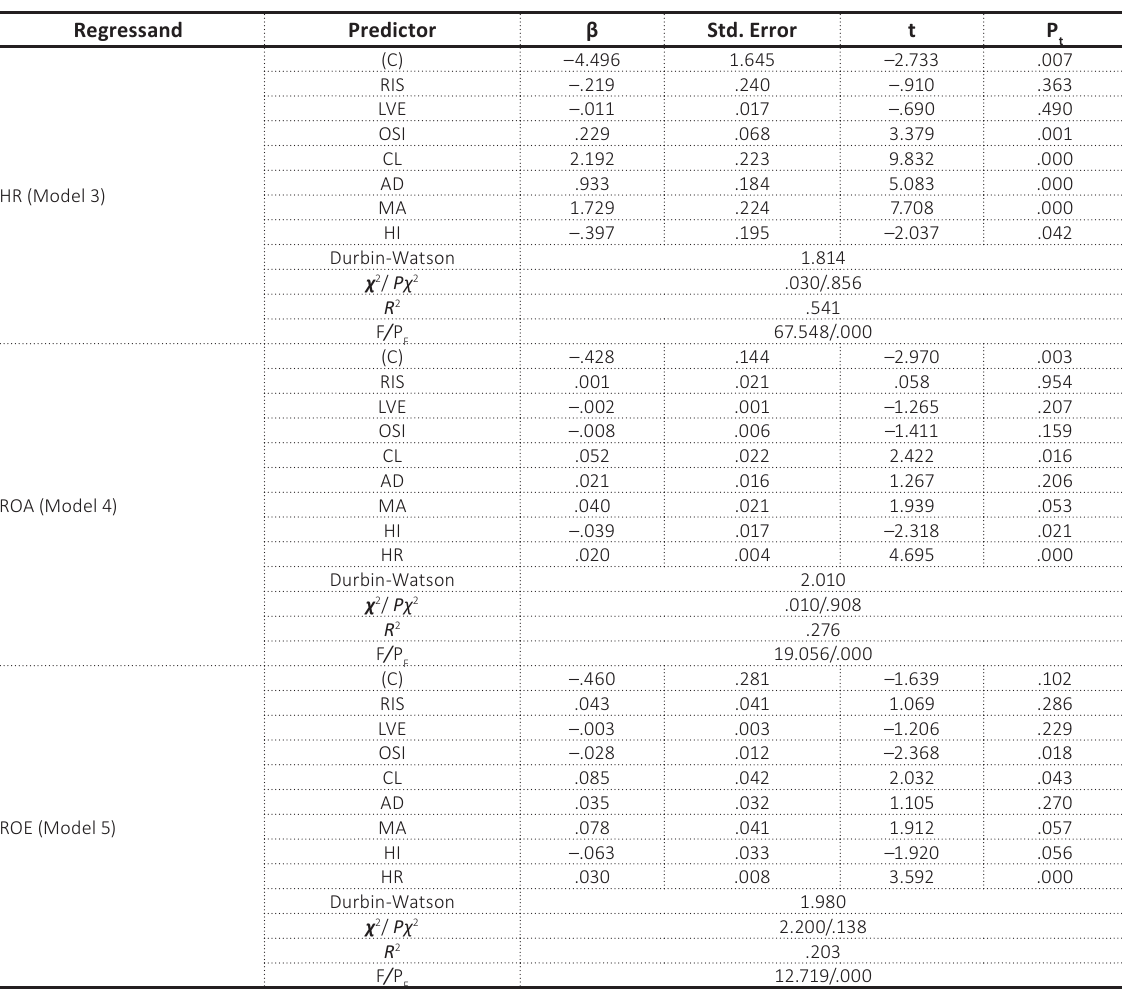
Table 5. Multiple regression analyses for